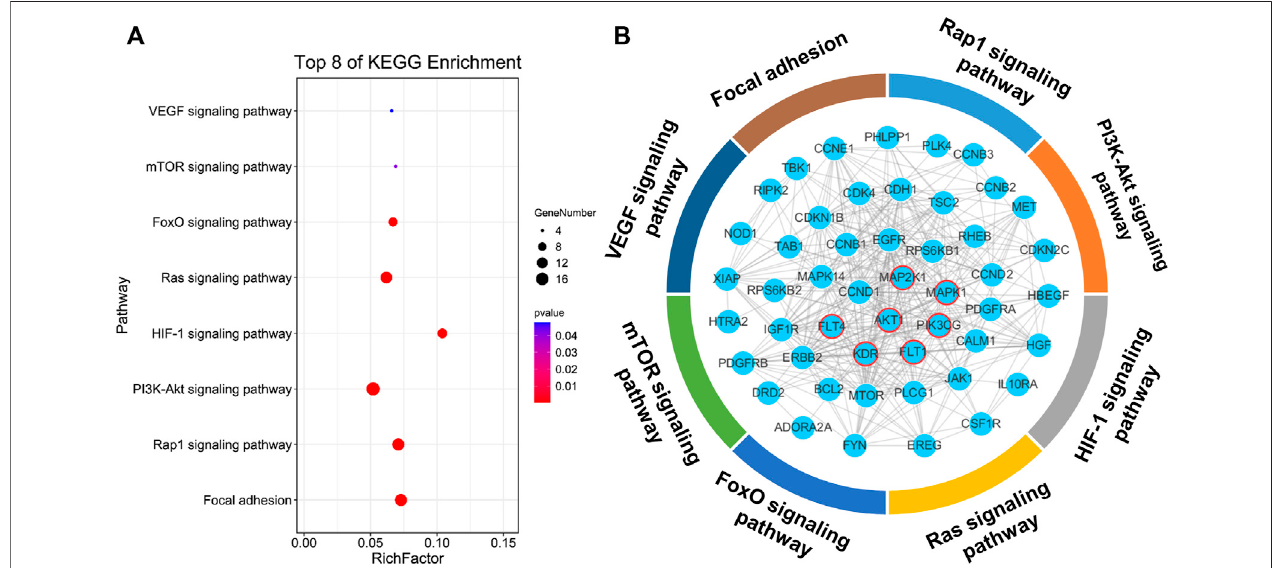
FIGURE1| TargetpredictionofKYZ. (A) KYZ ’ stargetswereobtainedusingtheSwissTargetPredictionandthenthetargetswereputintotheDAVIDdatabasefor KEGG analysis. Eight pathways associated with vascular disease in KEGG enrichment analysis was demonstrated. (B) The protein interaction network between eight vascular disease-related pathways, the proteins circled in red are the direct target of KYZ, other proteins were enriched in these pathways.